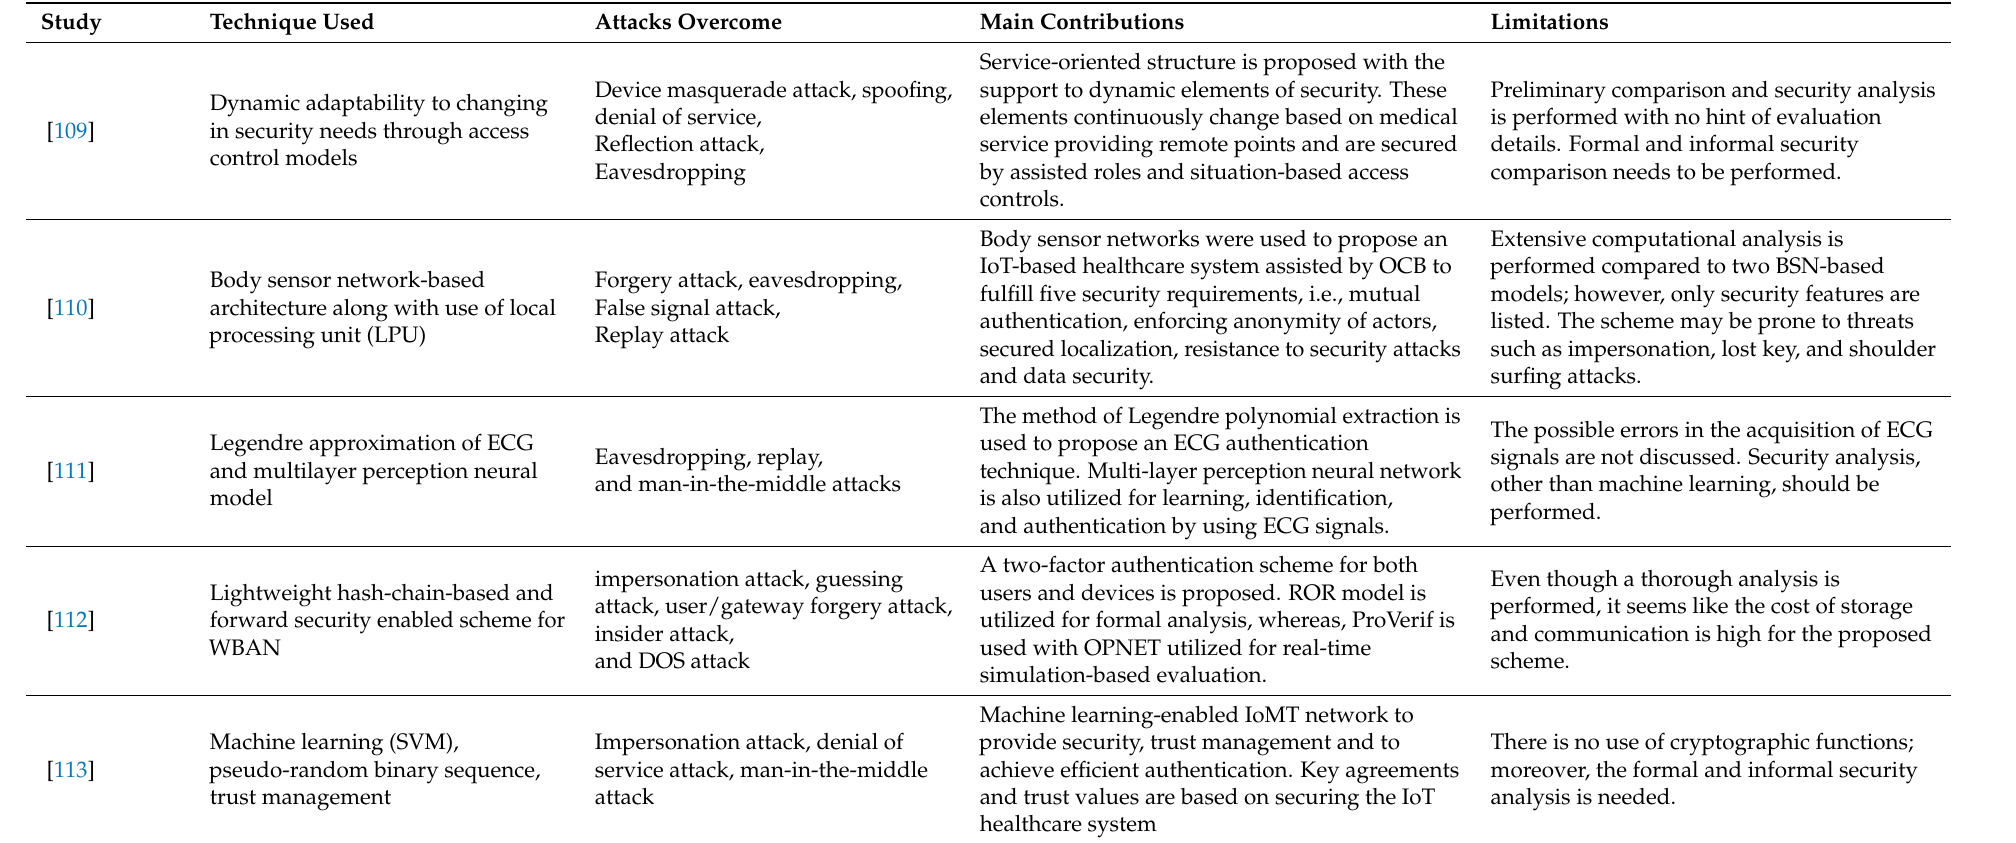
Table 4. Edge-based authentication techniques in IoT-enabled healthcare